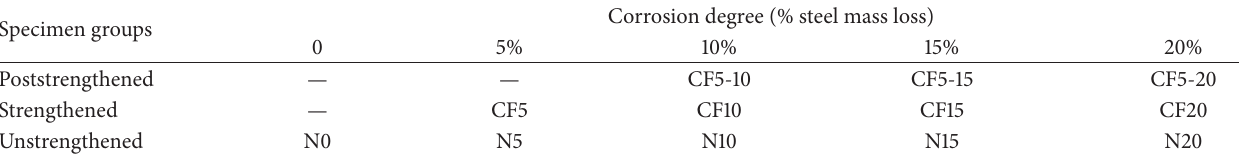
Table 1: Test program.